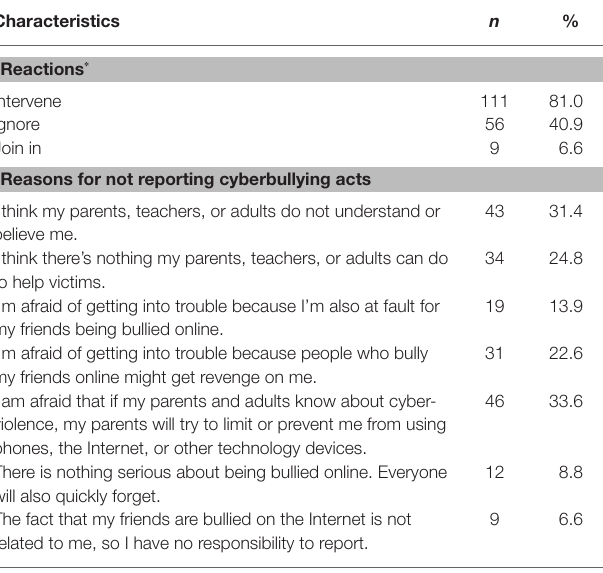
TABLE 3 | Reactions and reasons for not reporting among cyberbullying observation ( n = 137).